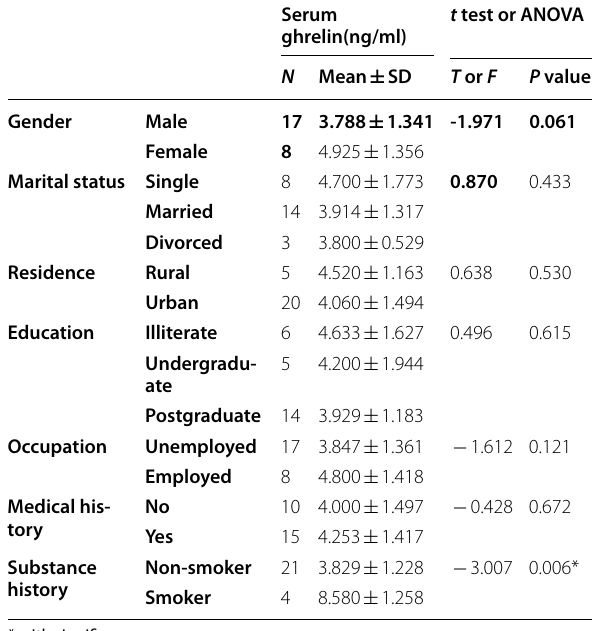
Table 2 Serum ghrelin level among cases and controls Table 3 Serum ghrelin in relation to demographic data and medical history of